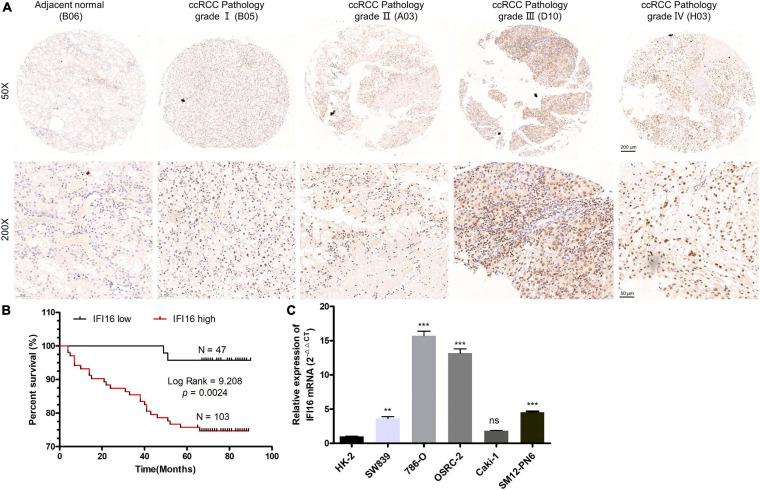
IFI16 expression profiles in ccRCC tissues and cell lines. (A) Representative images of IFI16 protein immunochemistry in unpaired and paired ccRCC tissues compared with adjacent normal kidney tissues. Magnification: ×50, ×200; (B) The Kaplan-Meier overall survival curve of ccRCC patients (n = 150) according to IFI16 protein expression (p = 0.0024, by the log-rank test). (C) Expression level of IFI16 in ccRCC cell lines were screened by qRT-PCR. (ns no significant; **P < 0.01; ***P < 0.001).